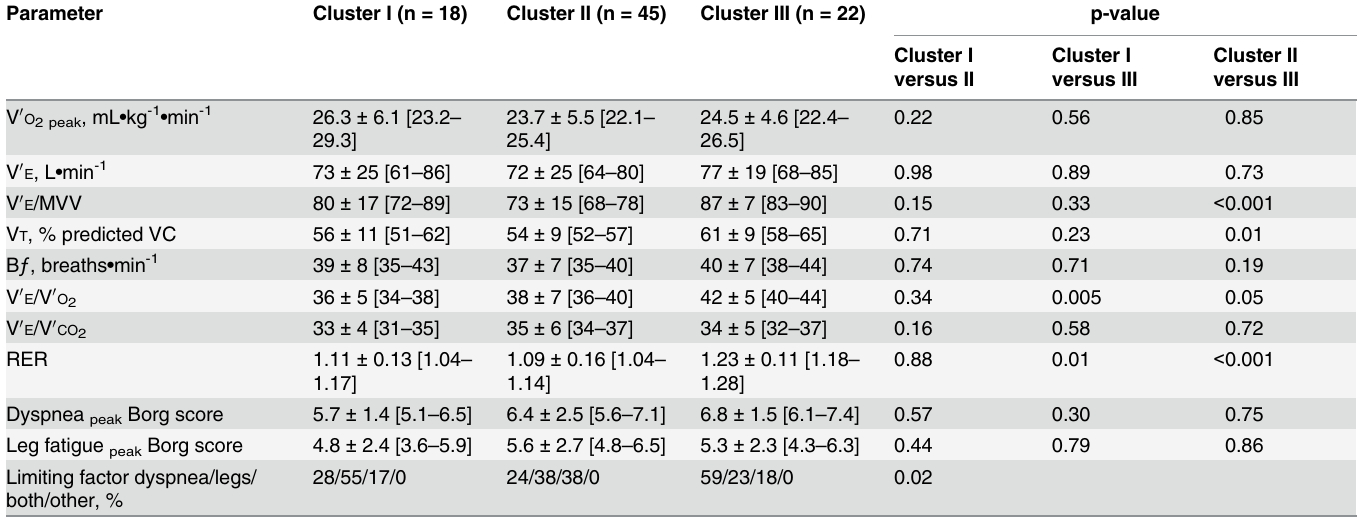
Table 3. Peak physiological response to exercise for patients with GOLD grade COPD by